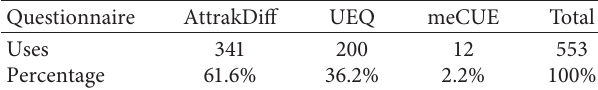
Table 3: Total number of uses of standardized